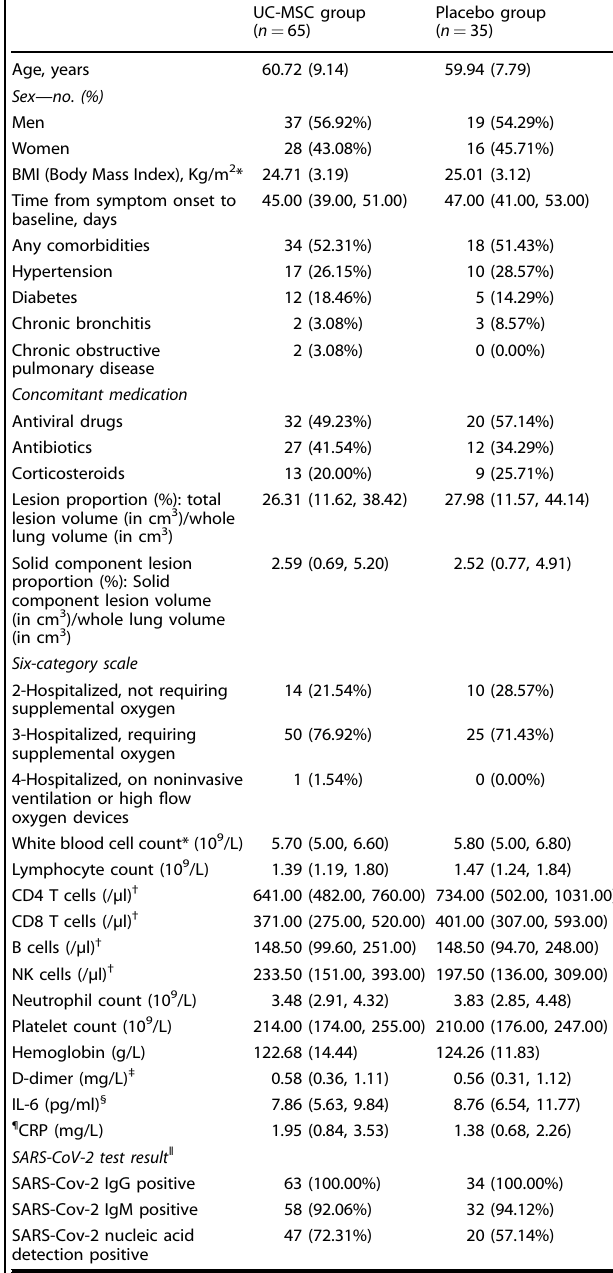
Table 1. Baseline patient